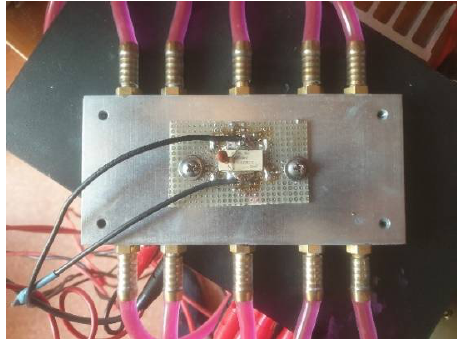
Figure 9. View of the tested transistor mounted on the heat